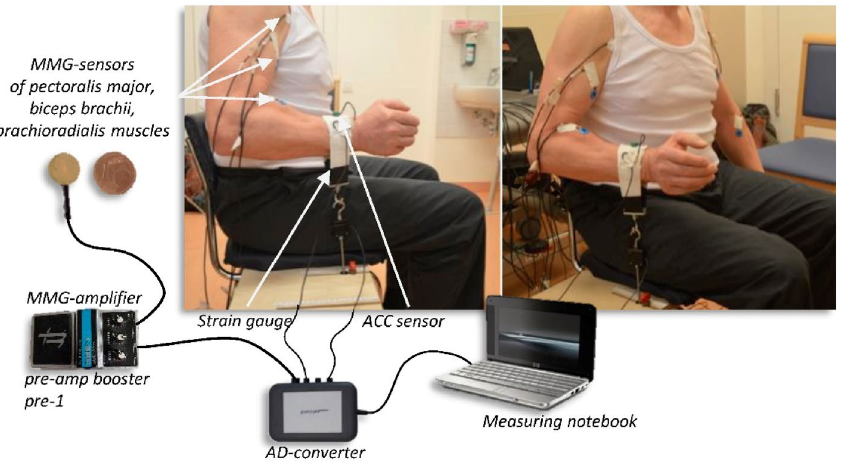
Figure 1. Setting for the unilateral isometric motor task. The MMG-sensors were fixed above the biceps brachii, brachioradialis and pectoralis major pars clavicularis muscles and amplified using the Nobels pre-amp booster pre-1. The strain gauge, which was fixed by a strap to the forearm of the participants, recorded the force and the ACC-sensors captured the motion and accelerations of the forearm. All signals were transmitted through an AD-converter to the measuring